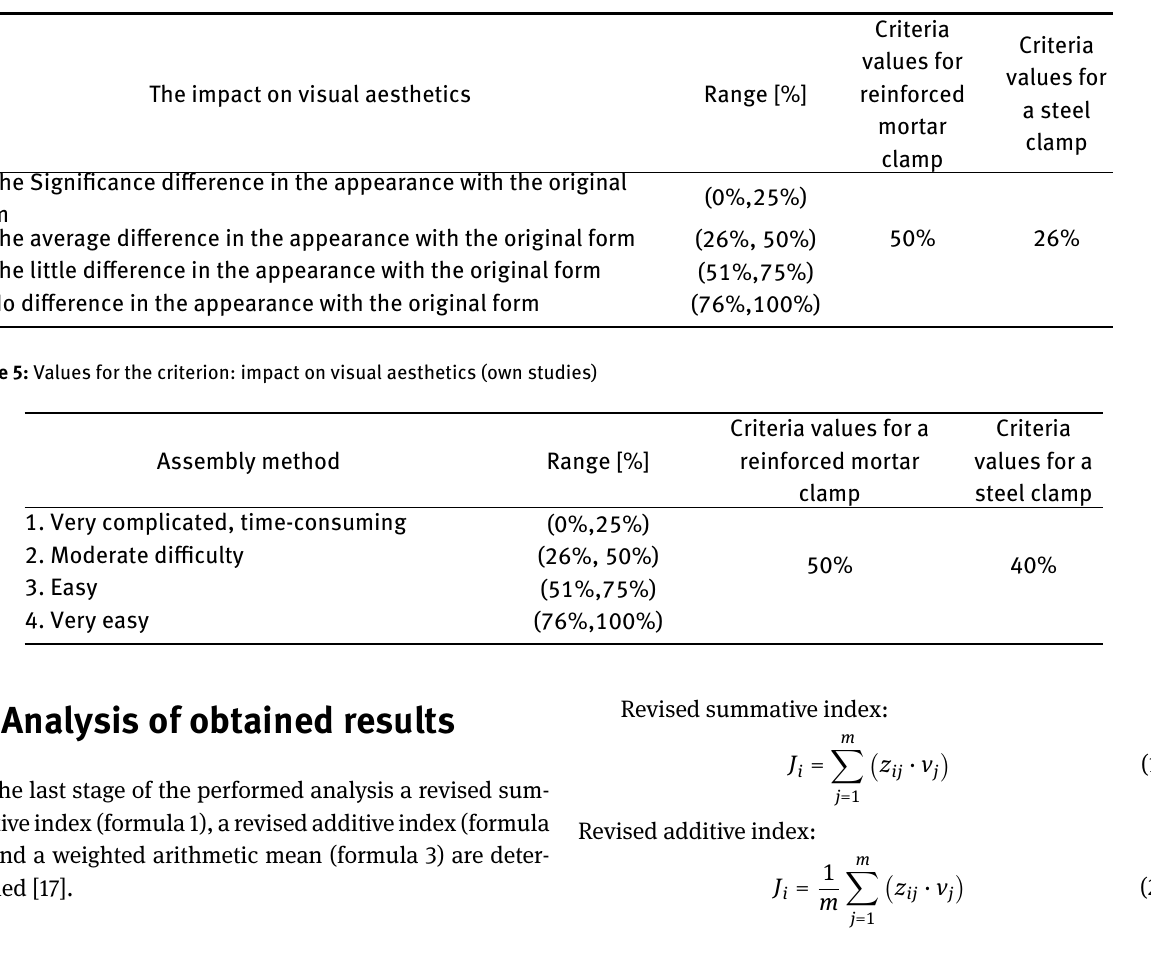
Table 4: Values for the criterion: impact on visual aesthetics (own studies)